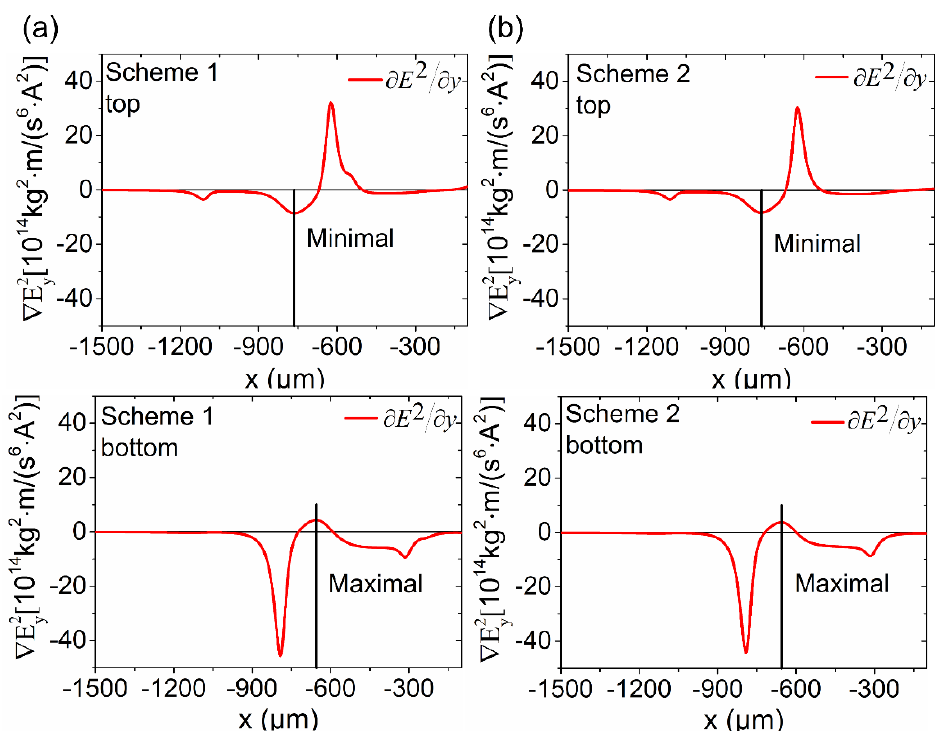
Figure 5. Distribution of ∇ E 2 y near the top wall and bottom wall (at the distance of 2 µ m from the top and bottom wall). ( a ) The distribution in scheme 1; ( b ) the distribution in scheme 2. The minimal and maximal represented the extreme value, and the droplet generation would be activated at these points, where the DEP force was the greatest off the wall.